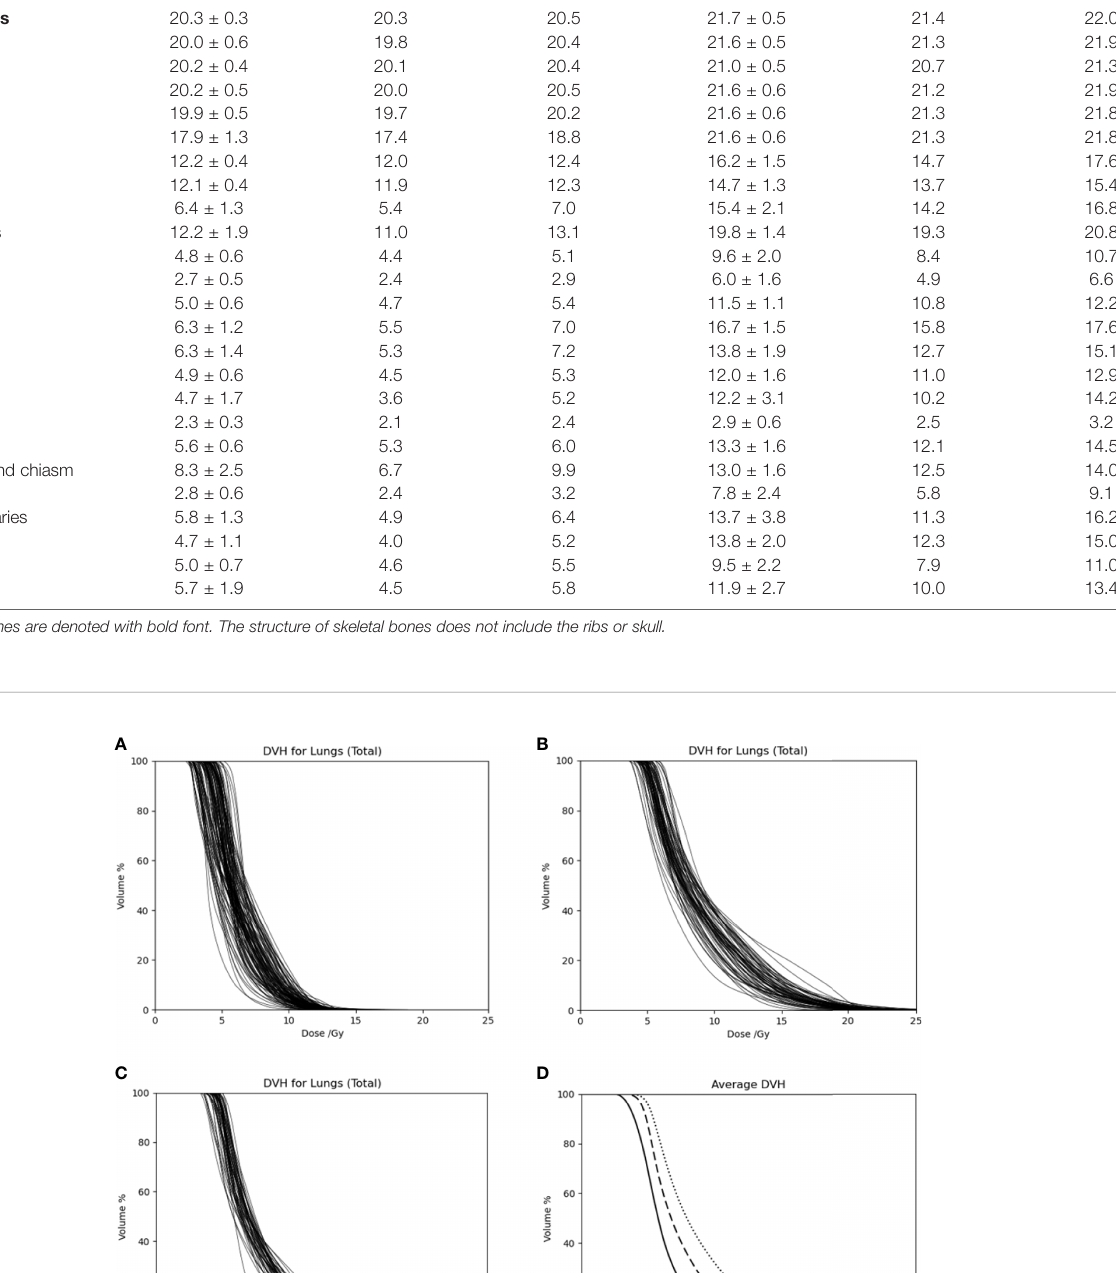
TABLE 5 | Statistics of D80 and D10 for each structure with the 20-Gy cohort. Structure